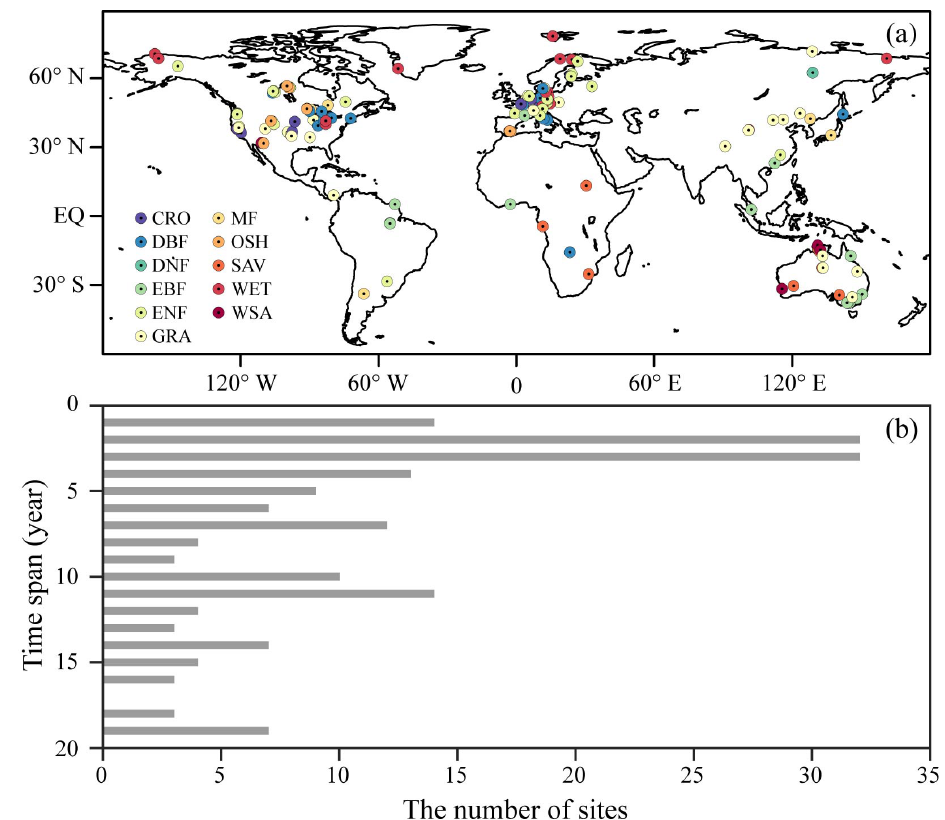
Figure 1. (a) Spatial distribution of 181 in situ flux EC sites across the world and (b) the number of sites for different time spans. See Sect. 2.1.5 for definitions of the abbreviations used in (a)